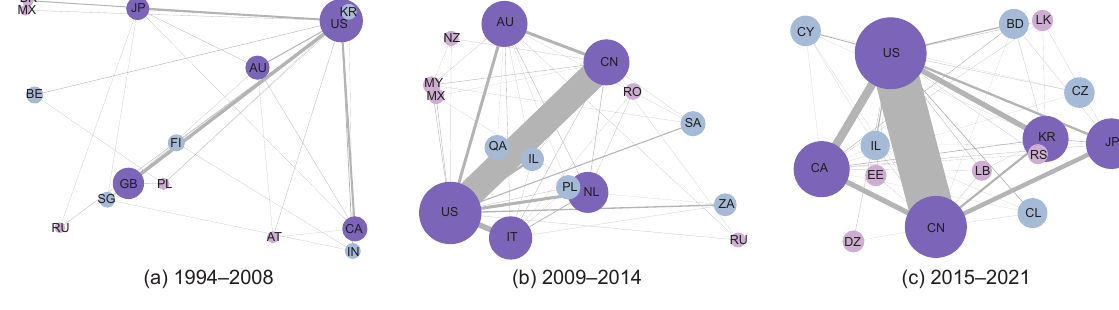
Fig. 6 Country collaboration network in different time stages. Table 6 Country pairs with the highest weights in the country collaboration network in different time stages. Rank